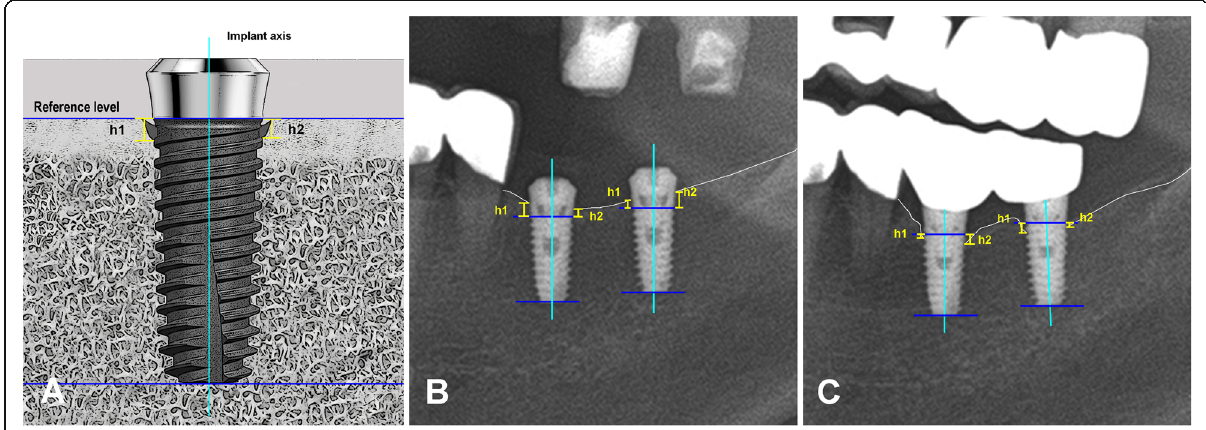
Fig. 3 An example of the measurement of the MBL on the mesial and distal sides of the implant system ( a ) using panoramic radiographs taken after placement ( b ) and 1 year after loading ( c ). Marginal bone level on the mesial side, h1; marginal bone level on the distal side, h2. Both radiographs ( b – c ) depict the Stella® implant system 4 mm in diameter and 8.5 mm in length placed in the same